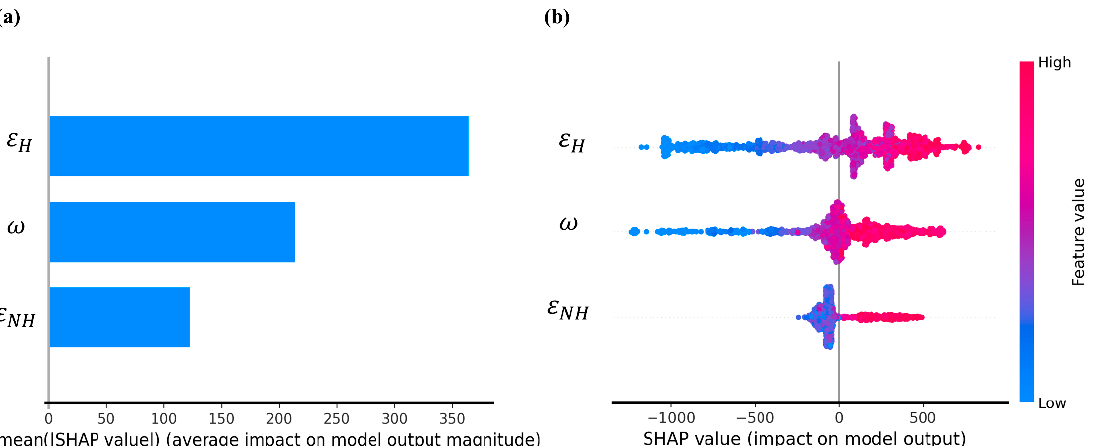
Figure 7. Feature importance analysis of each feature descriptor. ( a ) Feature importance is summa- rized with a bar chart, and the features are ordered by the average absolute value of SHAP; ( b ) feature importance is summarized with a density scatter plot.